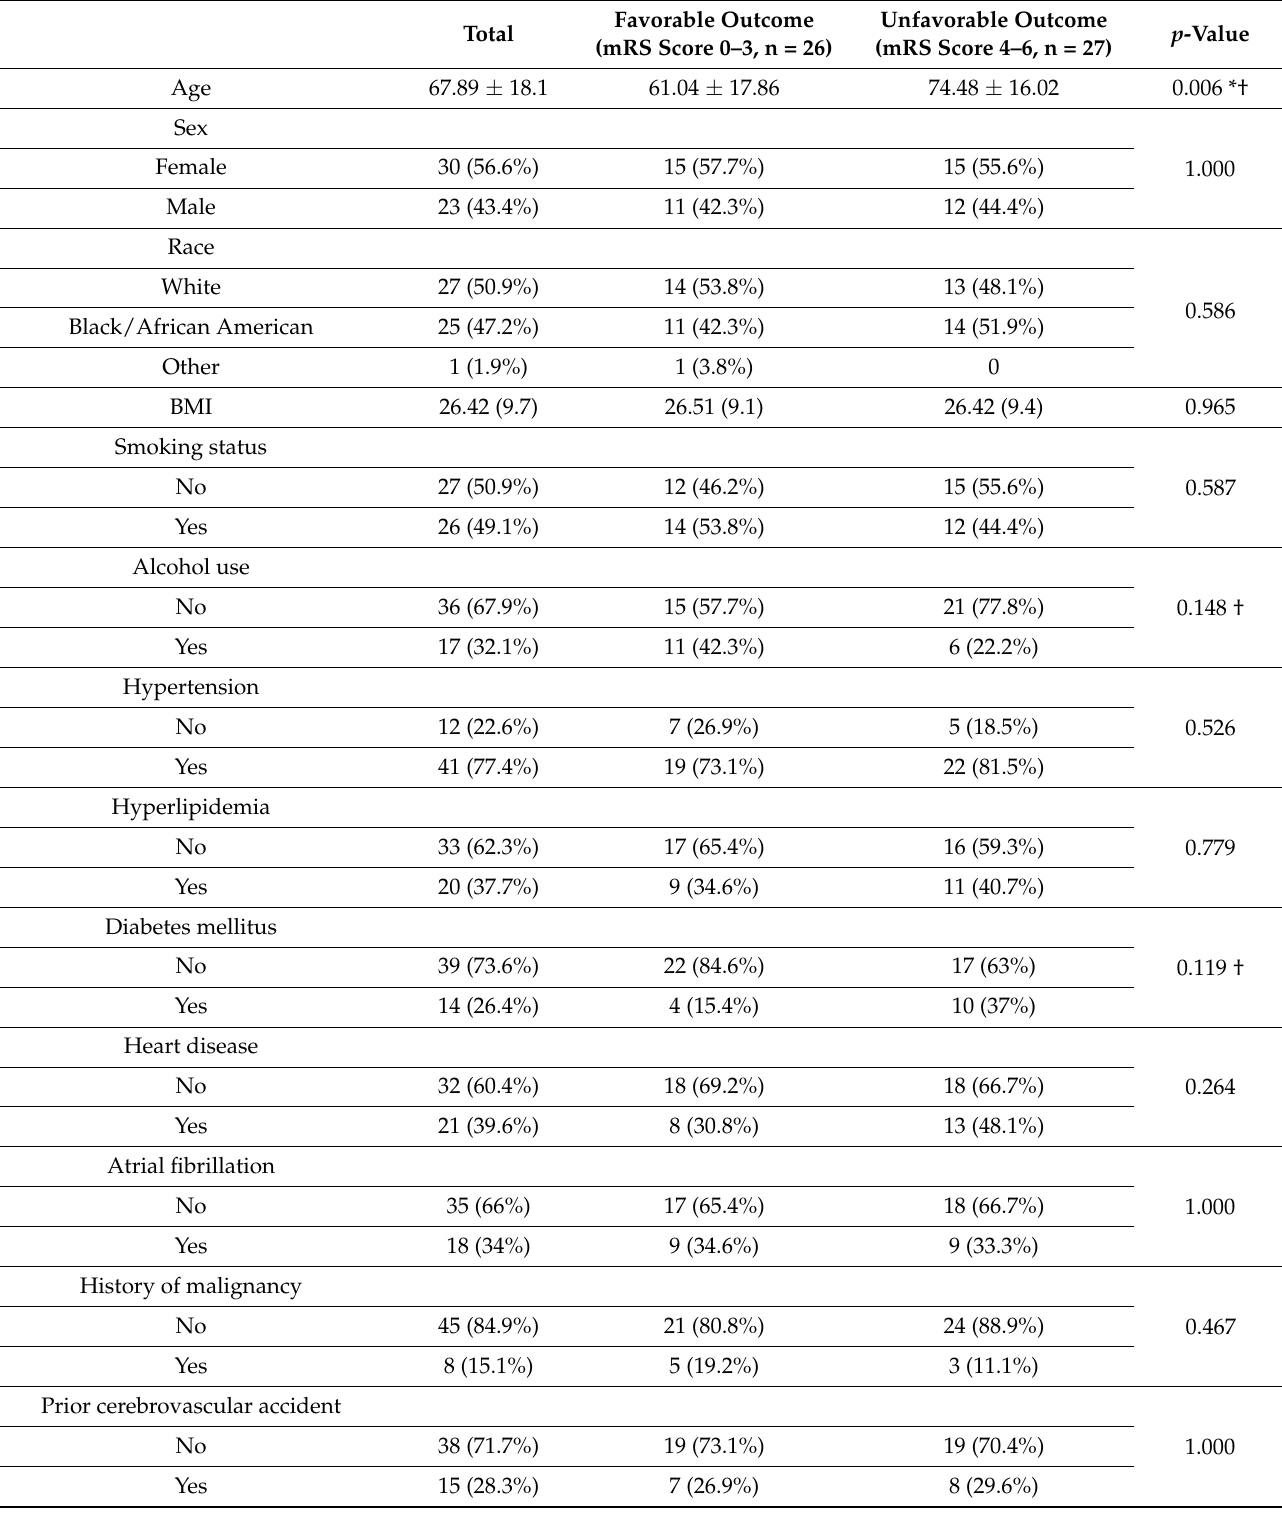
Table 1. Baseline clinical, laboratory, and radiologic characteristics of the patient